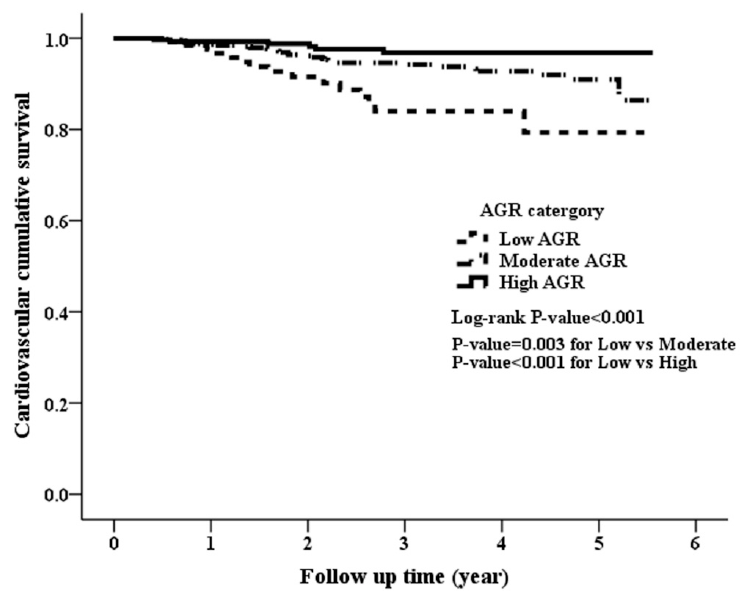
Figure 2. Kaplan-Meier curve of cumulative survival free of cardiovascular disease-related mortality according to the AGR groups (log-rank test, p < 0.001).